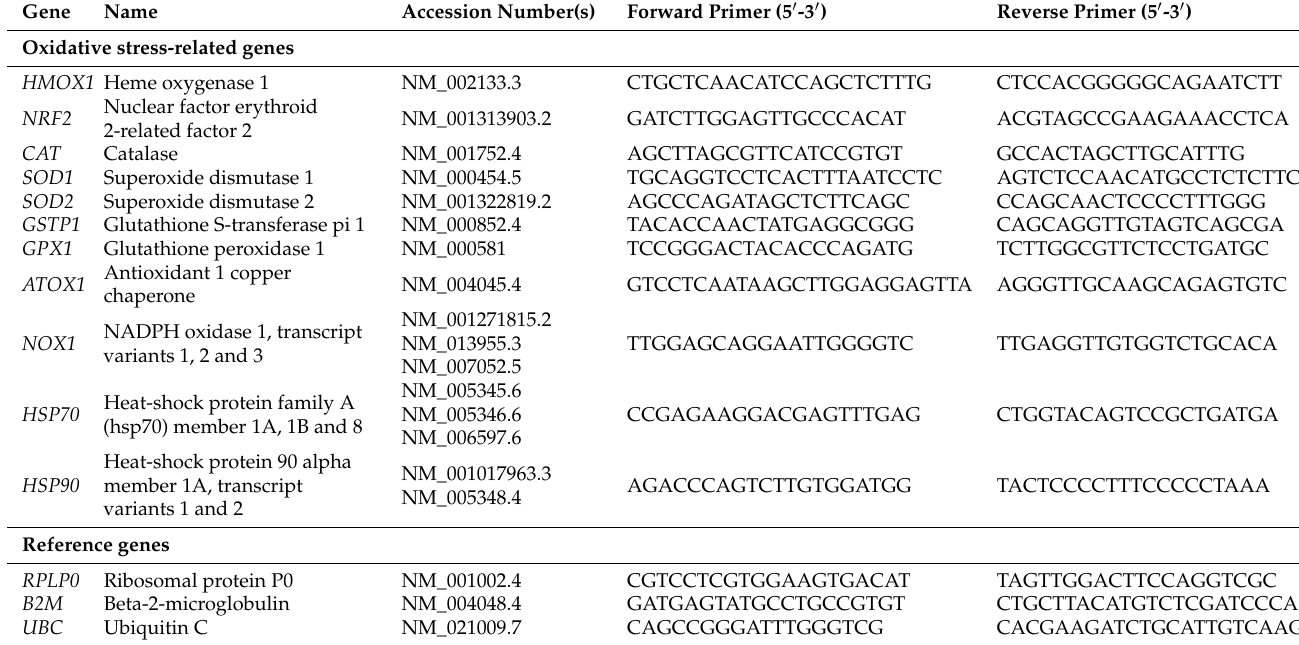
Table 2. Selection of genes and primer